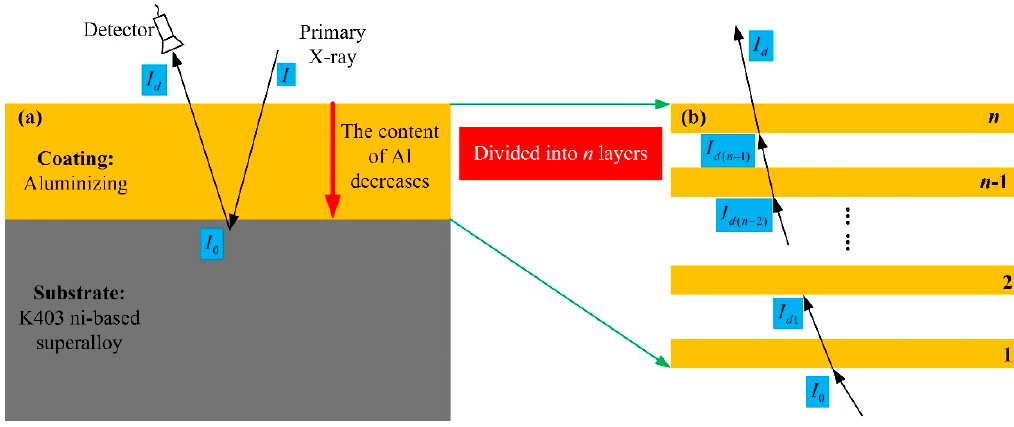
Figure 3. Simplified structural model. ( a ) refers the simplified coating structure; ( b ) refers the divided layers of aluminized coating.